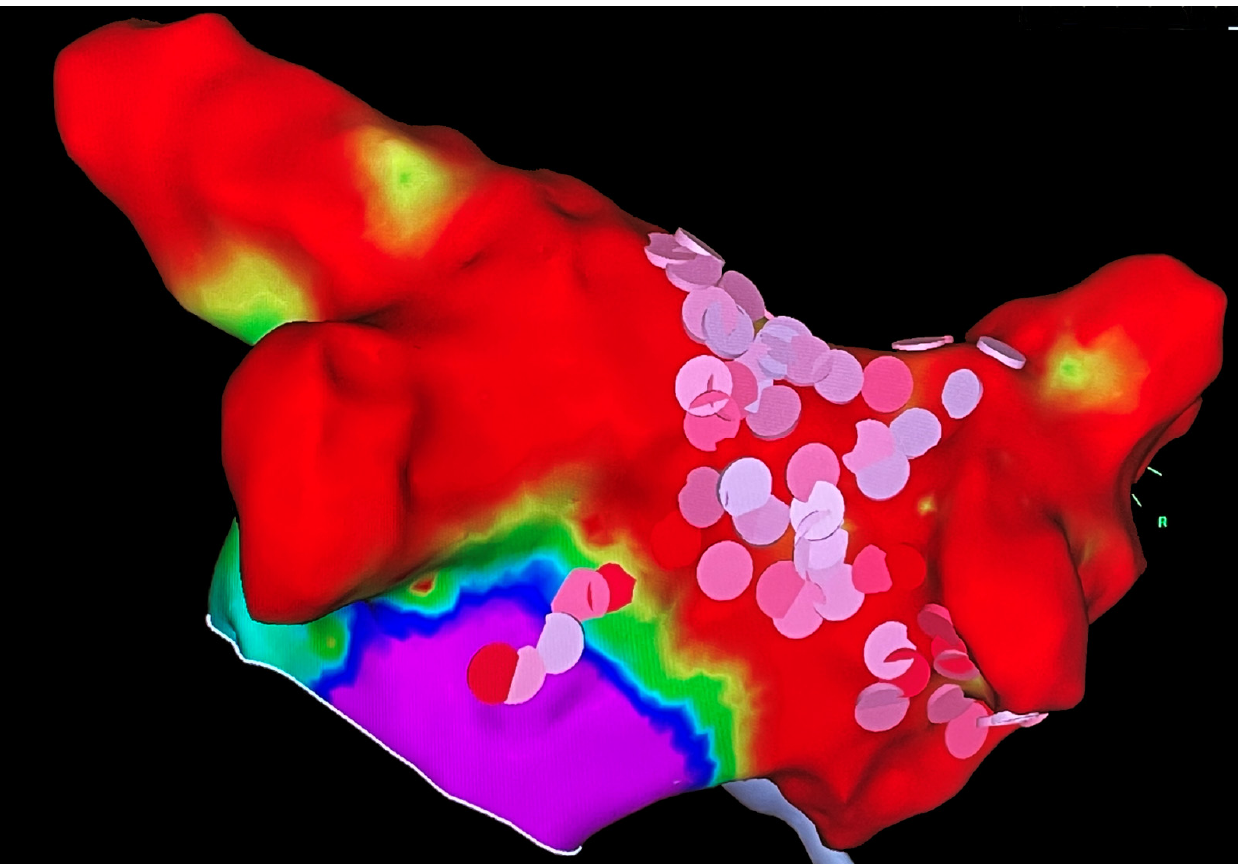
Figure 2. Three-dimensional bipolar voltage map of the left atrium after radiofrequency catheter ablation of persistent AF; pink dots indicate radiofrequency pulses on the posterior wall.